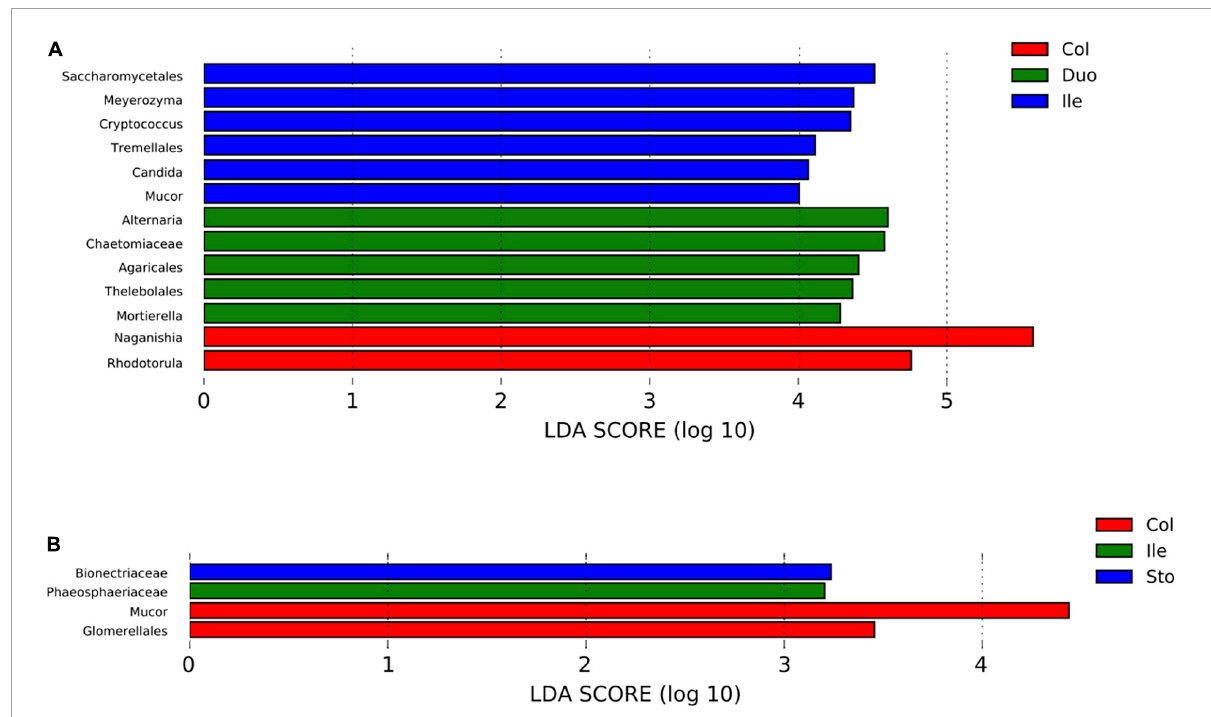
FIGURE4 Linear discriminant analysis (LDA) effect size (LEfSe) identified the differences in fungal taxa in different regions of the gastrointestinal tract in the pigs (LDA score > 2.0, p < 0.05). (A) Batch 1, (B) Batch 2. Horizontal bars represent the effect size for each taxon. Sto: Stomach, Duo: Duodenum, Jej: Jejunum, Ile: Ileum, Cec: Cecum, Col: Colon.